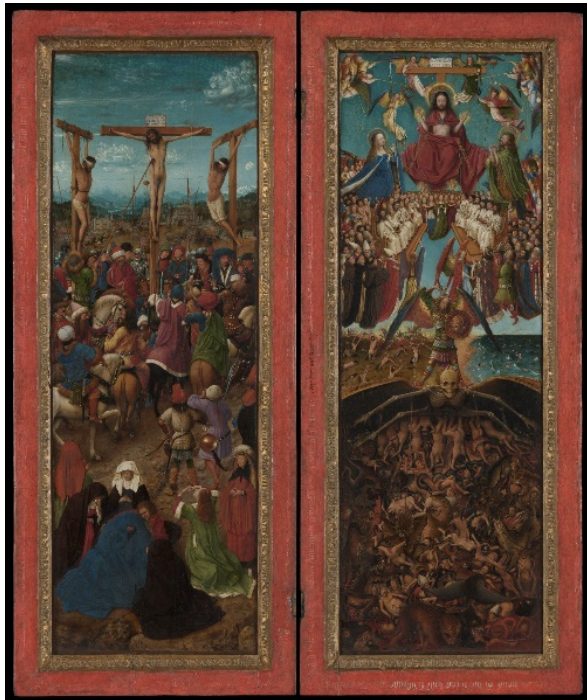
Figure 1. Jan van Eyck and his workshop, Crucifixion and Last Judgment ( the New York Diptych ), ca. 1440–1441, New York, Metropolitan Museum of Art.